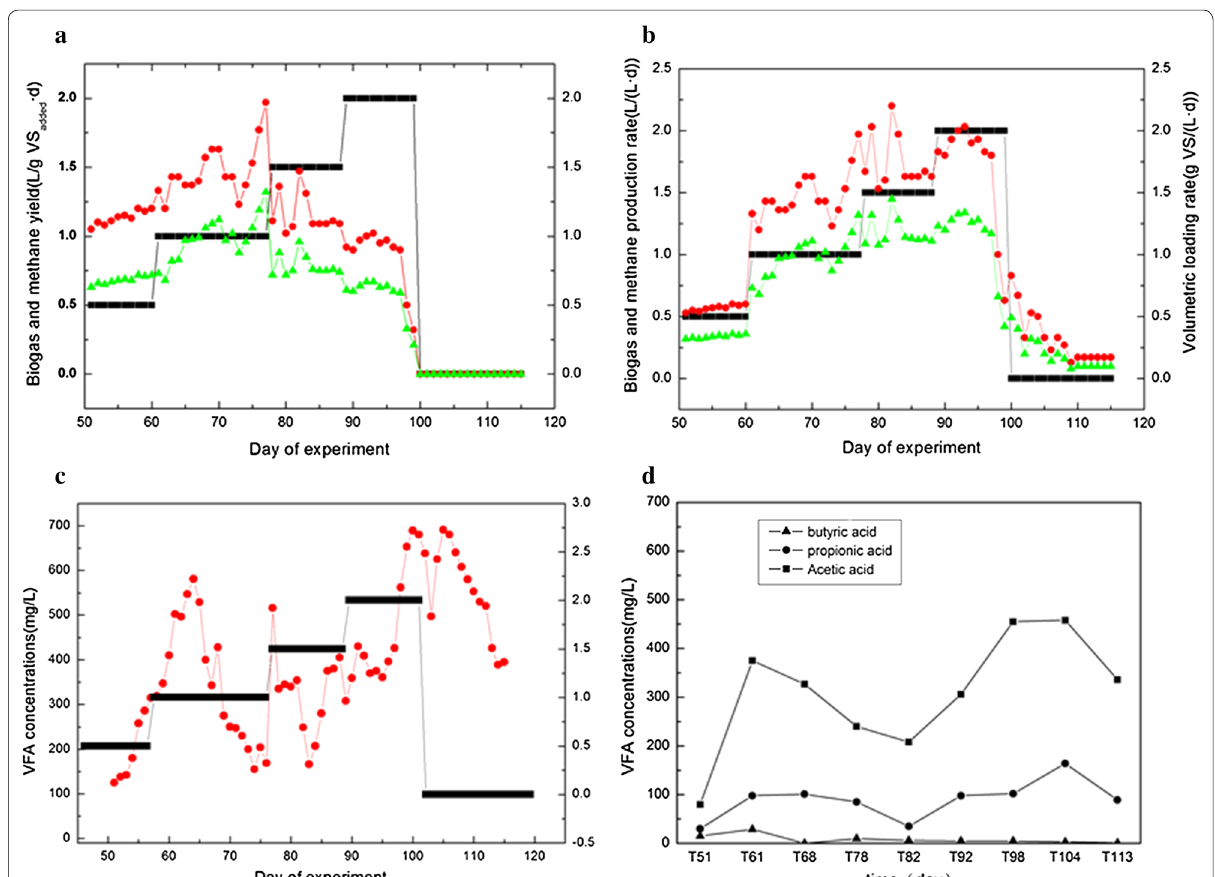
Fig. 1 Evolution of biogas/methane yield ( a ), volumetric biogas/methane production rate ( b ) and volatile fatty acids (VFAs) ( c , d ) in reactors with elevated OLR